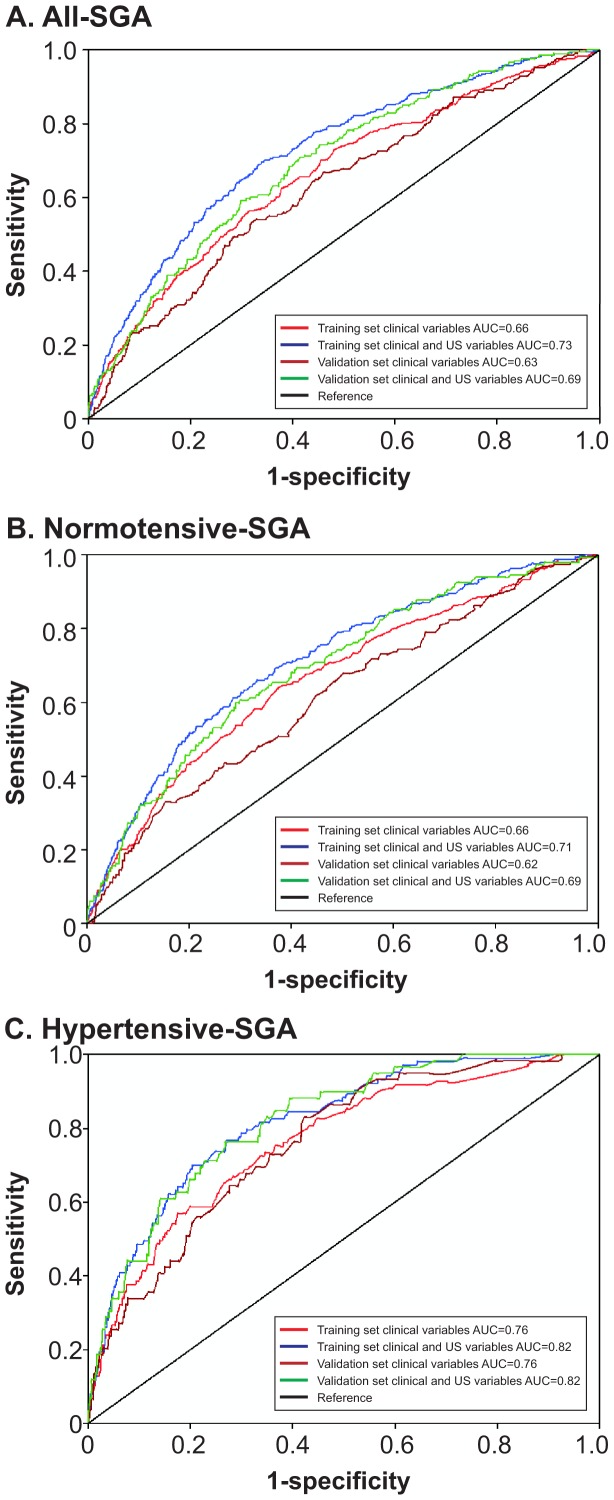
Receiver operating characteristics curves based on training and validation models of clinical risk factors at 15 weeks’ and ultrasound factors at 20 weeks’ gestation.A. All SGA B. Normotensive SGA C. Hypertensive SGA.